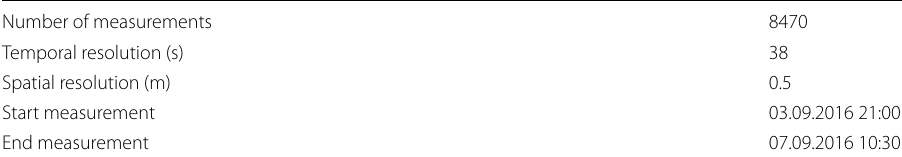
Table 2 DTS measurement overview